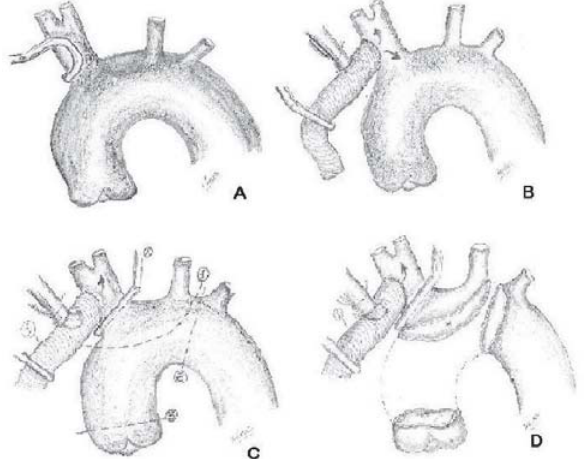
Fig. 1 – A: Posicionamento de “clamp” lateral no tronco braquiocefálico; B: Anastomose de tubo de Dacron 10 ou 12 mm (tubo I) no tronco braquiocefálico. Implante de cânula arterial no tubo I para início da circulação extracorpórea; C: Posicionamento de “clamp” no tronco braquiocefálico permitindo perfusão cerebral anterógrada seletiva durante para circulatória;